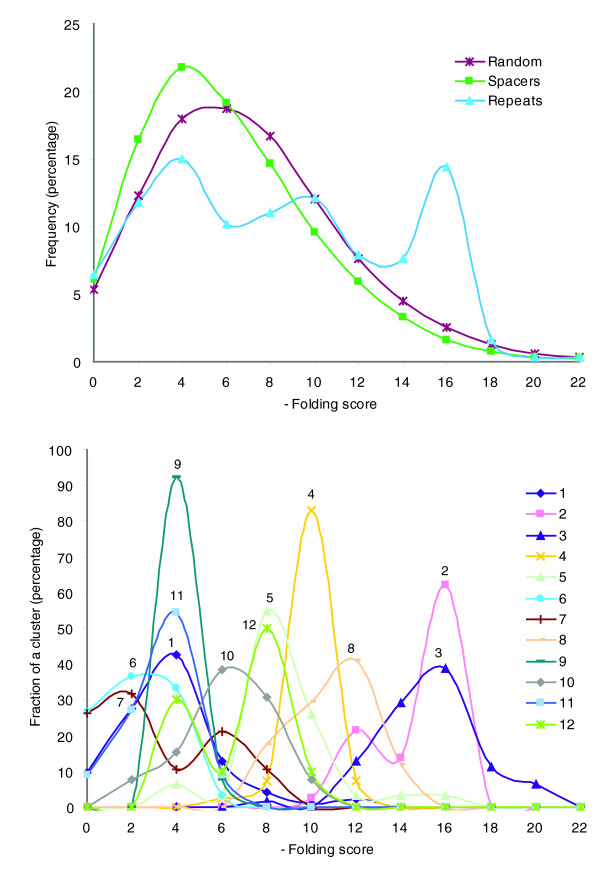
Distributions of folding scores of (a) all CRISPR repeats and all spacers, as compared to random sequences and (b) individual repeat clusters. X-axis, negative folding scores; Y-axis, fraction (percent) of total.